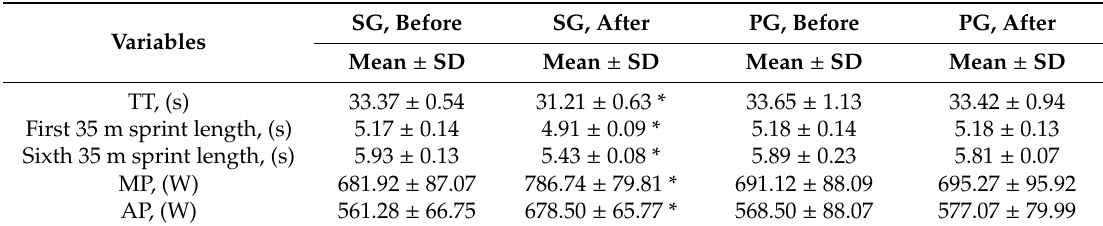
Table 3. The Running Anaerobic Sprint Test (RAST) results before and after the supplementation intervention.